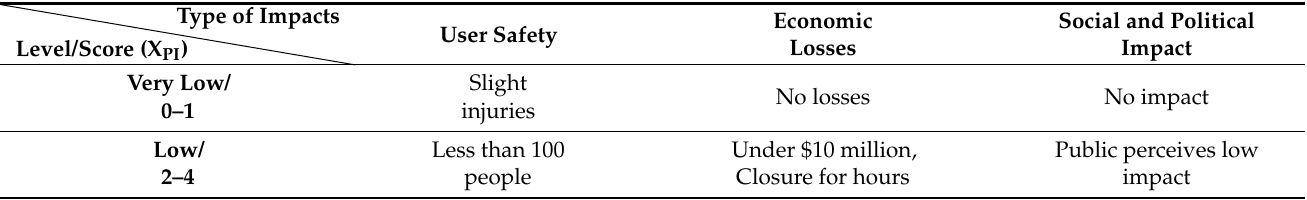
Table 3. Types of physical impacts (adapted to this study from